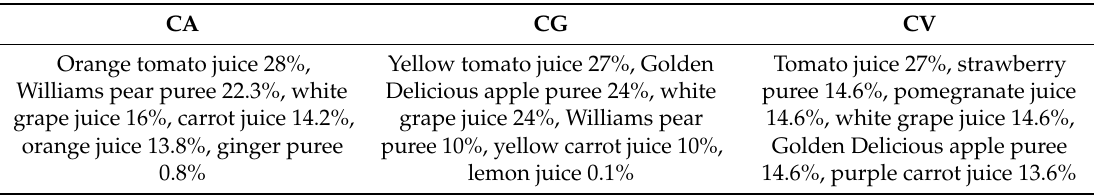
Table 1. Composition of tomato extract